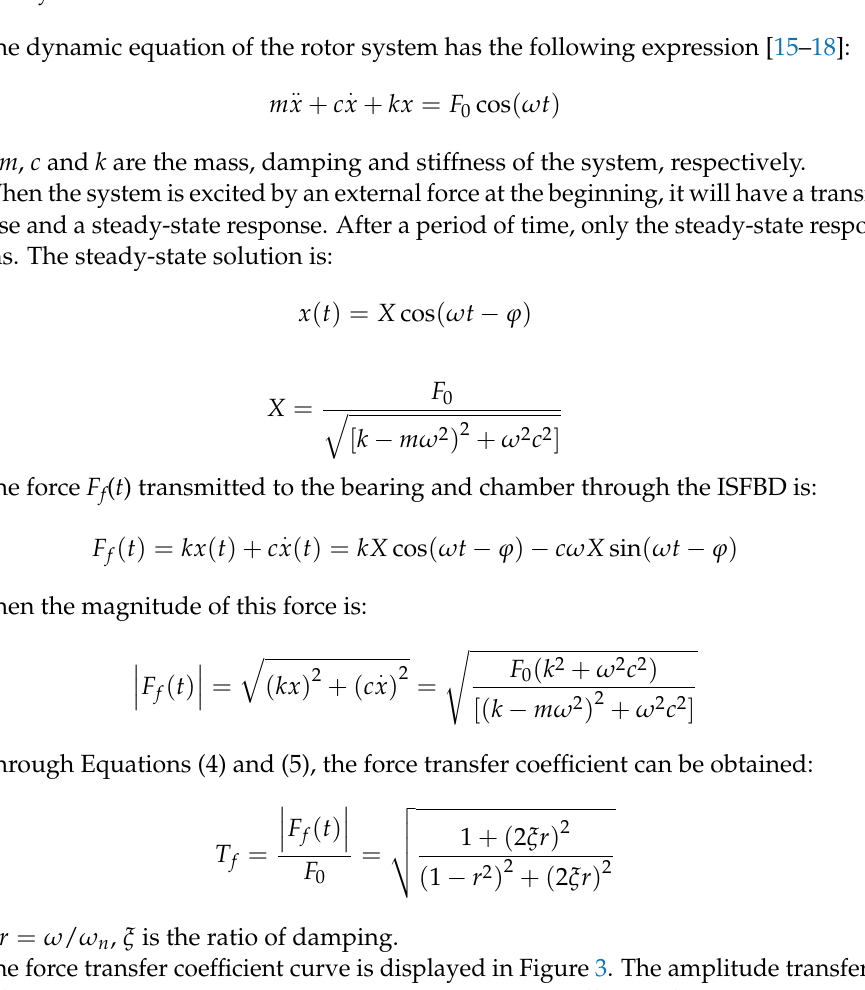
Figure 2. Dynamic model of ISFBD.